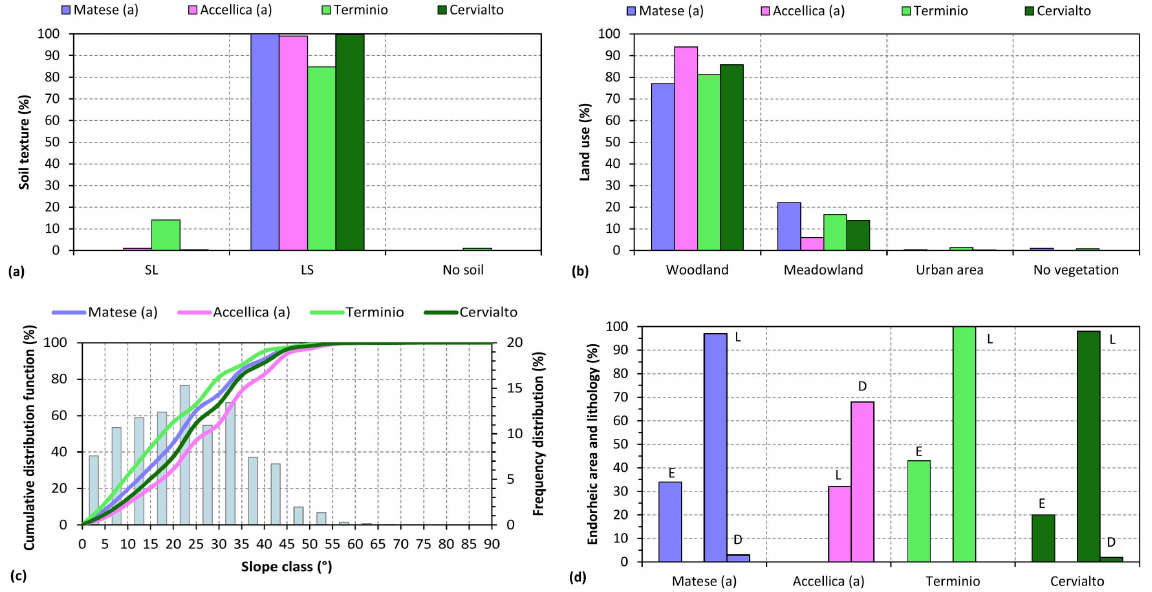
Fig. 2. Soil texture type, land use and geomorphological characteristics of the four sample karst aquifers. (a) Soil texture frequency (SL Sandy Loam, LS Loamy Sand. (b) Land use frequency. (c) Slope of karst aquifers frequency. (d) Summit endorheic and plateau areas frequency ( E ) and lithology (L=limestone;